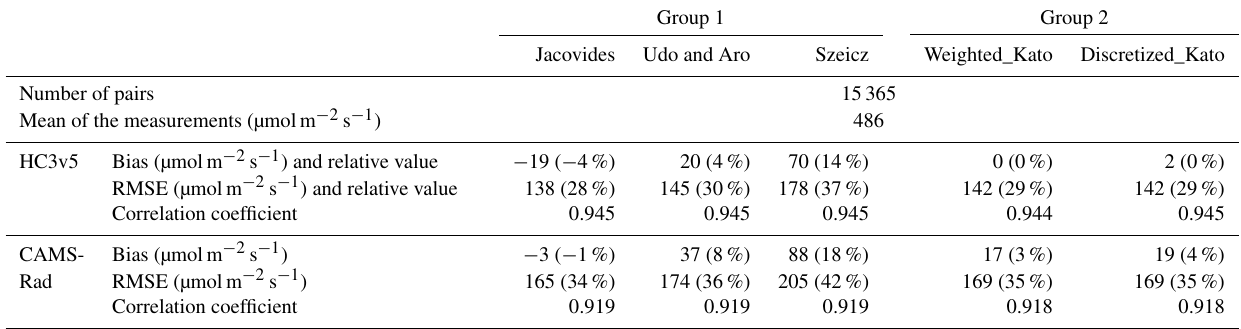
Table 3. Abbotts Hall. Number of coincident data, mean of measurements, bias and root mean square error (RMSE) and correlation coeffi- cient for the five PAR-satellite methods and for both HC3v5 and CAMS-Rad data sets.